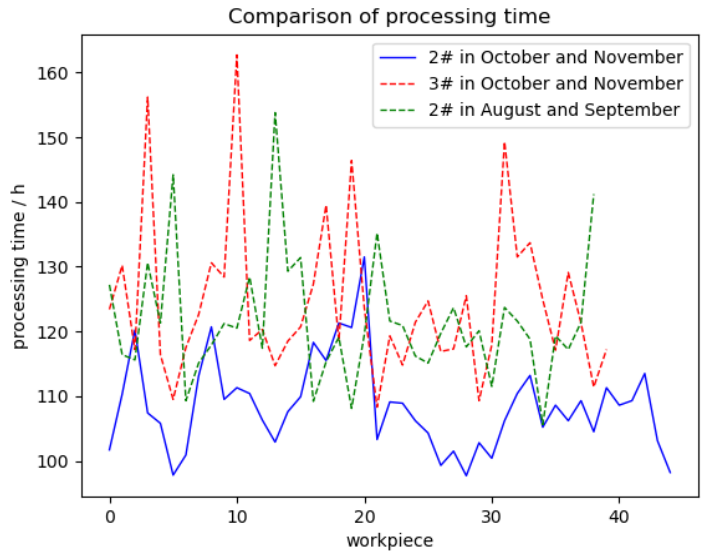
Figure 9. Line chart of the total processing time of the workpieces.